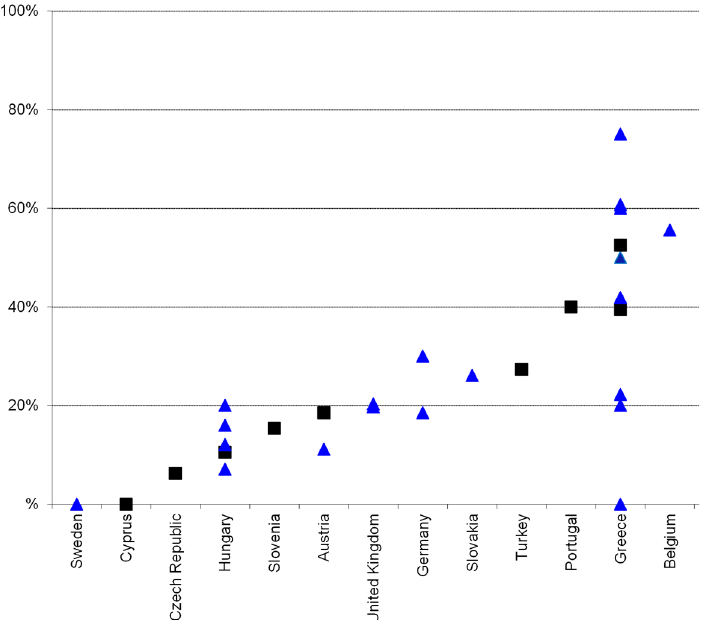
Figure 8. HCV antibody prevalence (%) among PWID injecting , 2 years in the EU, 2006–2011. Note Figure 8: Source EMCDDA, 2013. (http://www.emcdda.europa.eu/stats13 # inf:displayTables); black squares are data with national coverage, blue triangles are data with sub-national (local, regional) coverage.